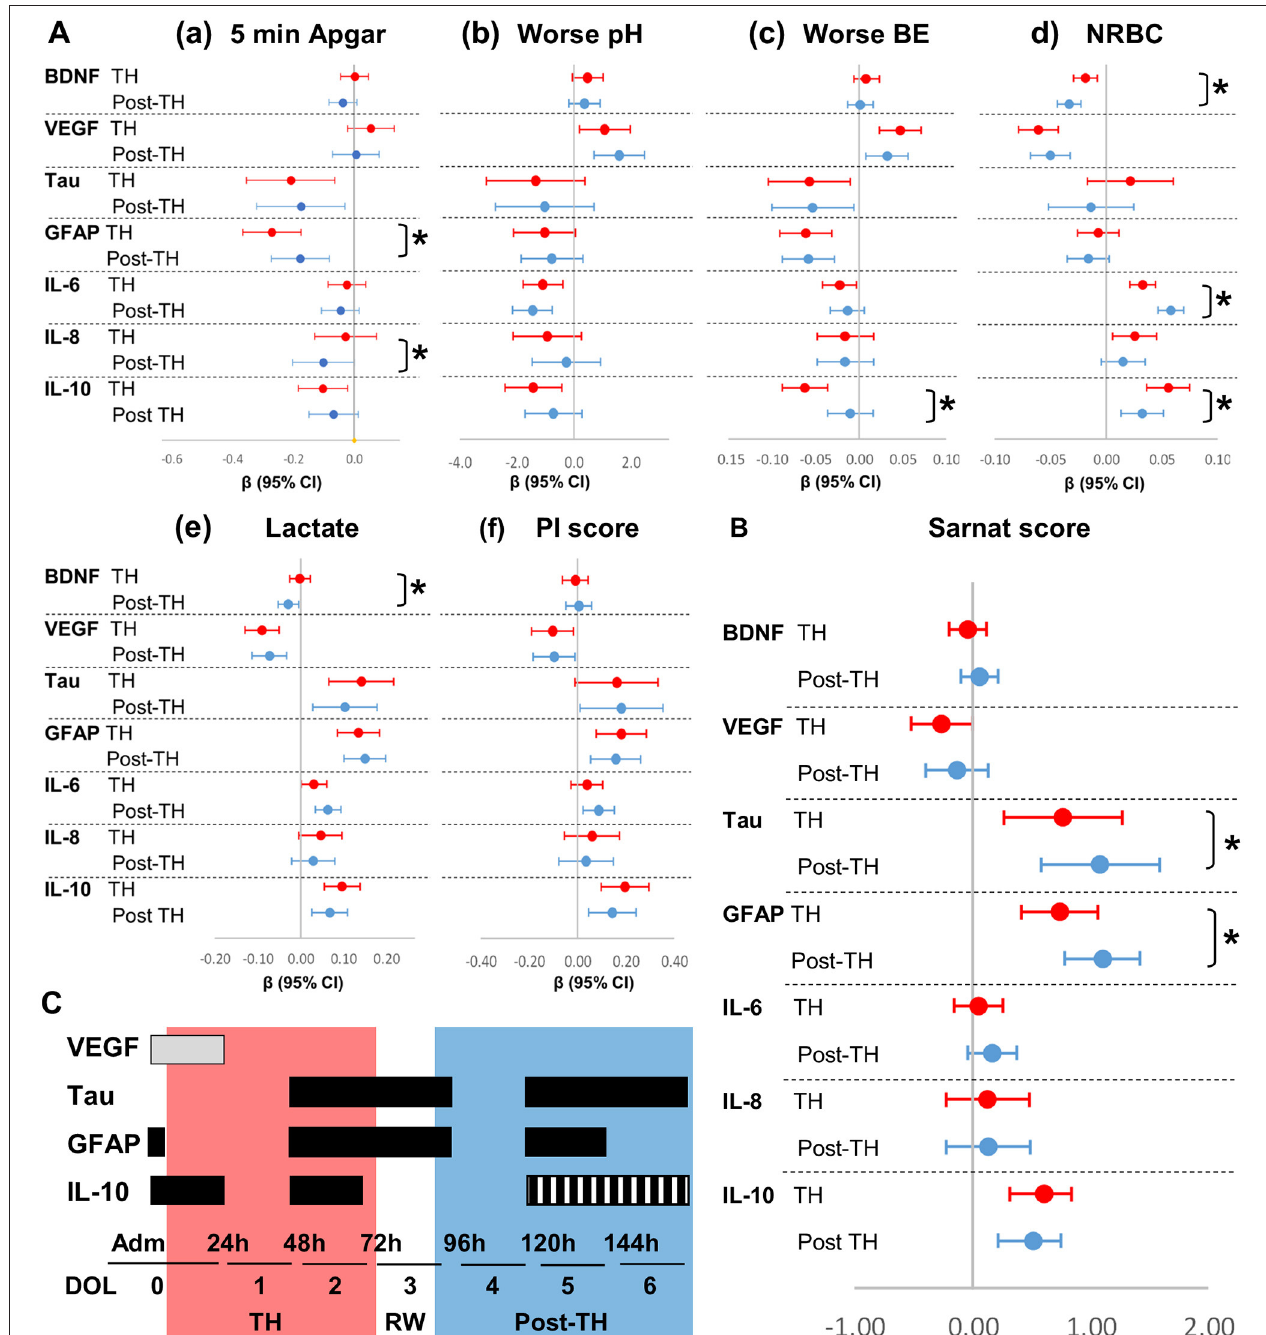
FIGURE 3 | Forest plots for adjusted associations between HI severity indicators and serum biomarkers by exposure to TH. Forest plots represent relationships adjusted for sex between (A) indicators of severity of HI insult and (B) Sarnat scores with biomarkers levels during (DOL 0–2, red) and after (DOL 4–6, blue) TH. Admission and DOL 3 (TH-rewarming) data were not included in the adjusted analysis intended to assess the effect of TH in trajectories. β -Coefficients reaching p -values < 0.05 in mixed model analysis adjusted for sex do not cross line at zero. * p -value comparing during and after TH periods is shown. The strength of associations, as determined by the β coefficients and CI (95%), is assessed by the distance from zero (reference line). (C) Proposed timeline to maximize utility of serum biomarkers against Sarnat score. Time intervals of maximum utility are shown in horizontal boxes in gray for levels expected to decrease and in black for levels expected to increase with higher HI brain injury. Red and blue zones represent the period during and after TH, respectively. Hashed box for IL-10 represent speculated increased levels with higher HI injury.